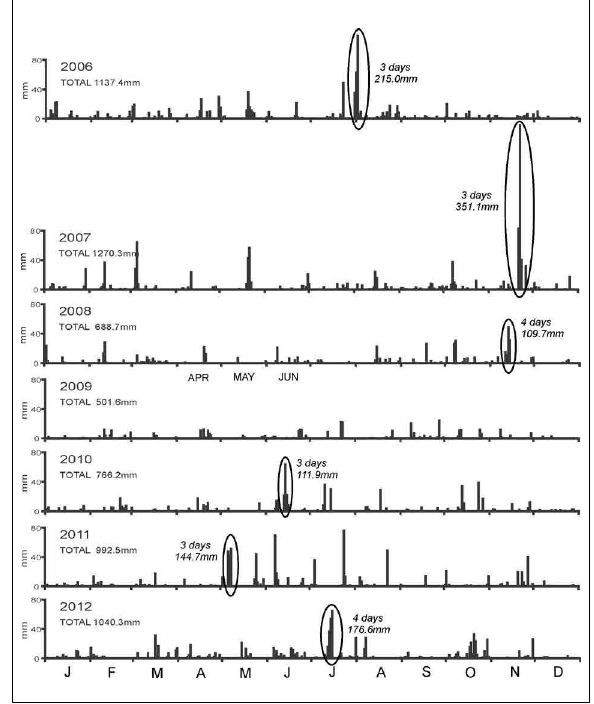
Daily rainfall from 2006 to 2012. Intense rainfall events of more than 100 mm over 3 or 4 days are circled.